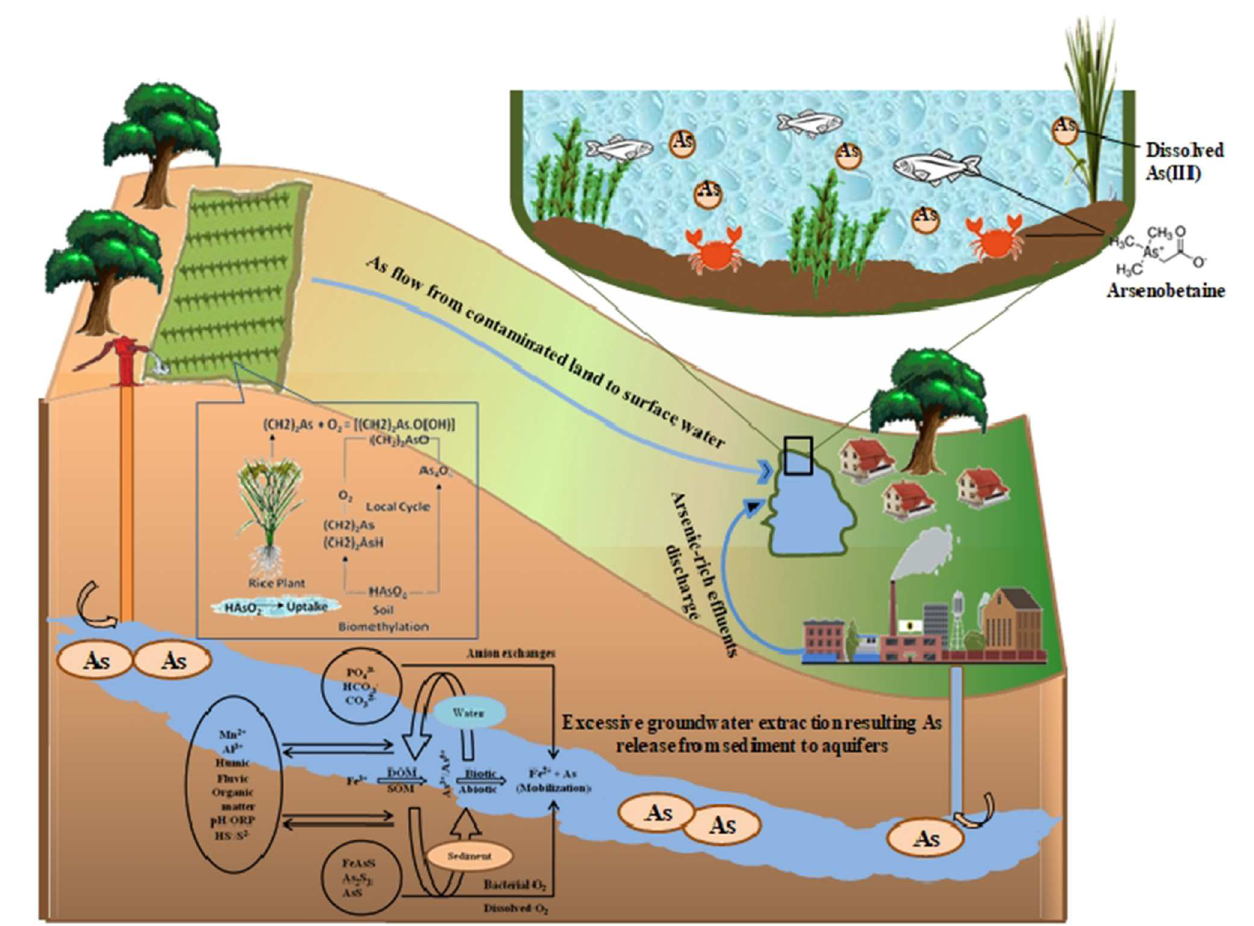
FIGURE 1 | The figure depicts the arsenic (As) cycle in various arenas such as groundwater to agricultural rice crops. The extraction and application cycle of arsenic has been depicted here showing the potential impacts of excessive groundwater extraction enriched in dissolved As from Fe-oxyhydroxides. The practice results in gradual deposition of As on agricultural top soil and contamination to crops cultivated on it. Industrial effluent discharge contaminated with As to the water bodies together with agricultural surface runoff leads to the water pollution and accumulation of different forms of As in aquatic